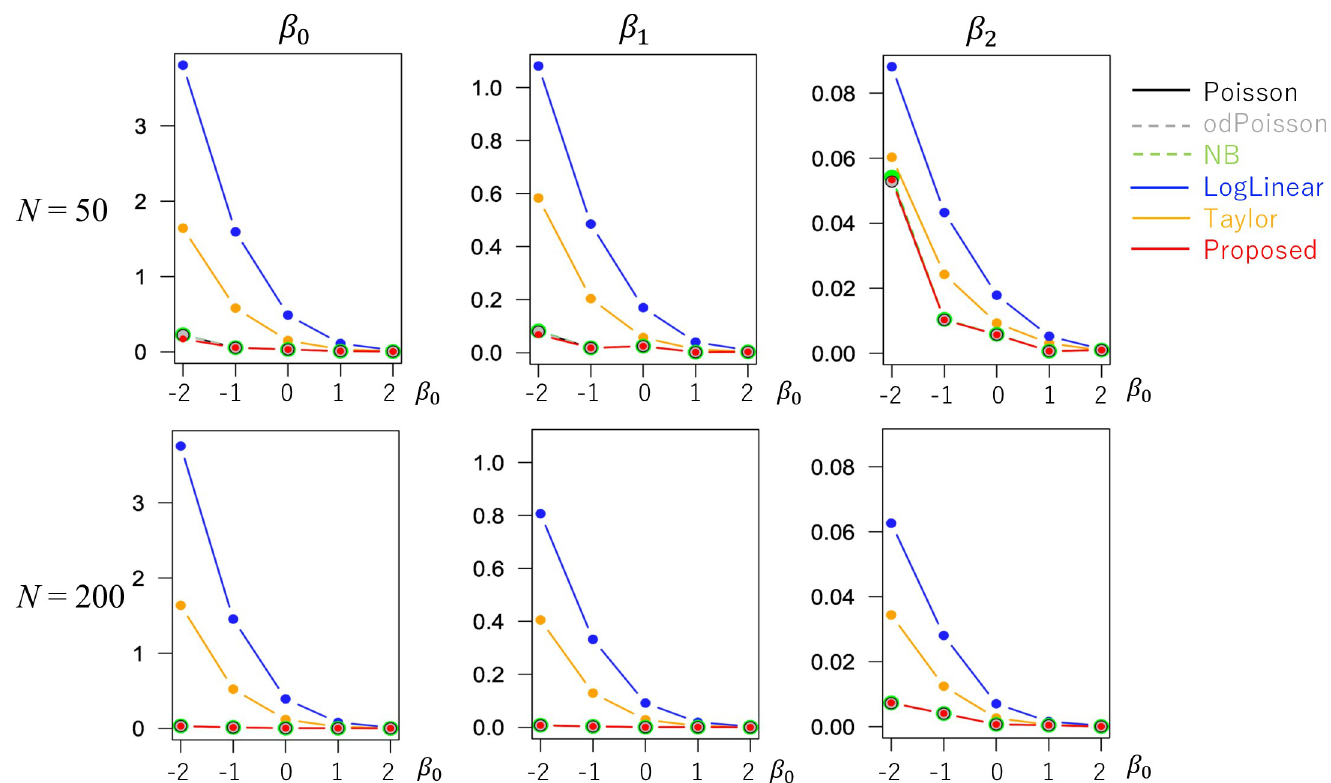
Fig 1. RMSE of the regression coefficients in cases without overdispersion ( σ 2 = 1.0) (x − axis: β 0 , y-axis: RMSE).